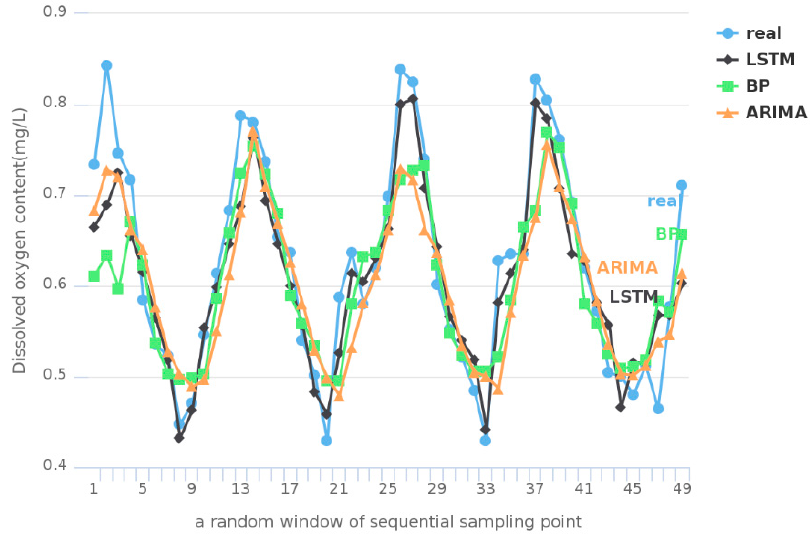
Figure 4. Prediction results of Tai Lake.